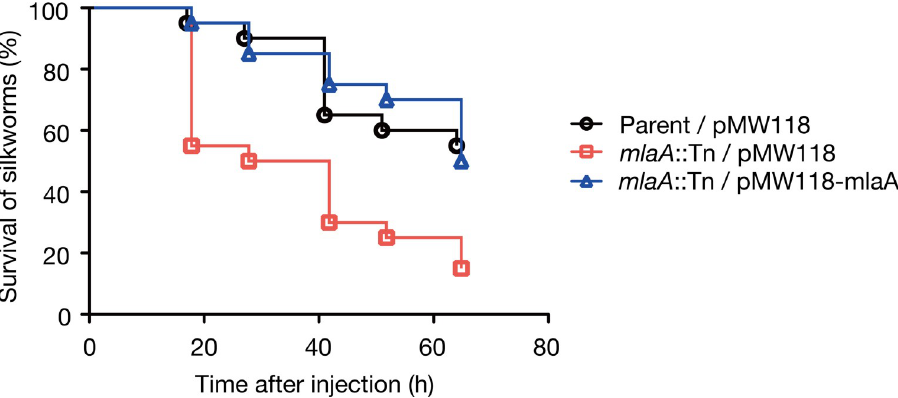
Fig 1. Knockout of mlaA increases E . coli virulence against silkworms. Silkworm killing activity of the parent strain transformed with an empty vector (Parent/pMW118), the mlaA- knockout mutant transformed with an empty vector ( mlaA ::Tn/pMW118), and the mlaA- knockout mutant transformed with pMW118-mlaA ( mlaA ::Tn/pMW118-mlaA) was examined. Silkworms were injected with bacterial cells (2 x 10 8 CFU) and survival was monitored. The experiment was performed twice and the data were pooled (n = 20). Log-rank test p value was less than 0.05 between Parent/ pMW118 and mlaA ::Tn/pMW118, or between mlaA ::Tn/pMW118 and mlaA ::Tn/pMW118-mlaA.